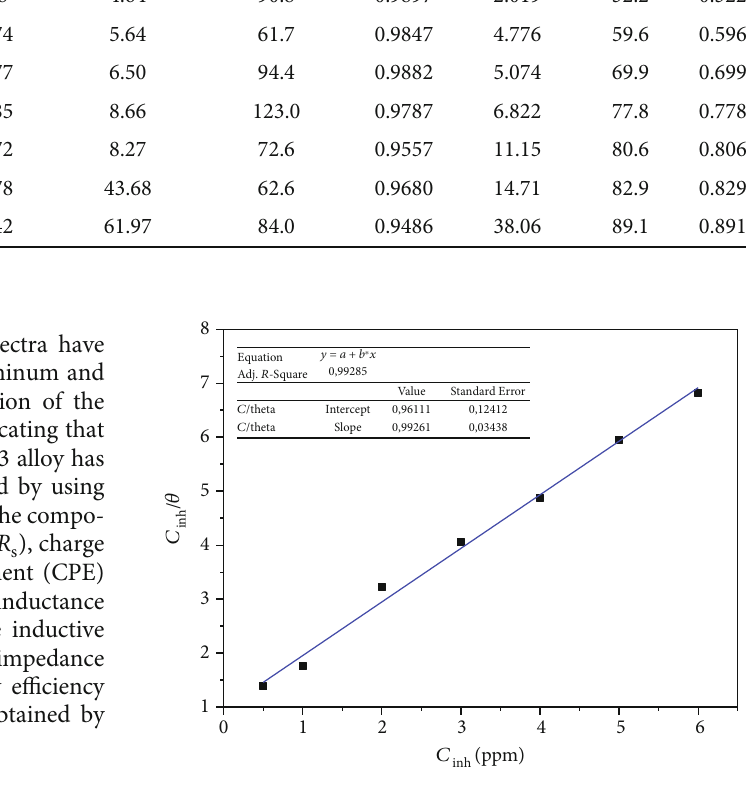
Figure 4: Langmuir isotherm line of AA3003 alloy in 1 M HCl medium with di ff erent concentrations of OMW at 298